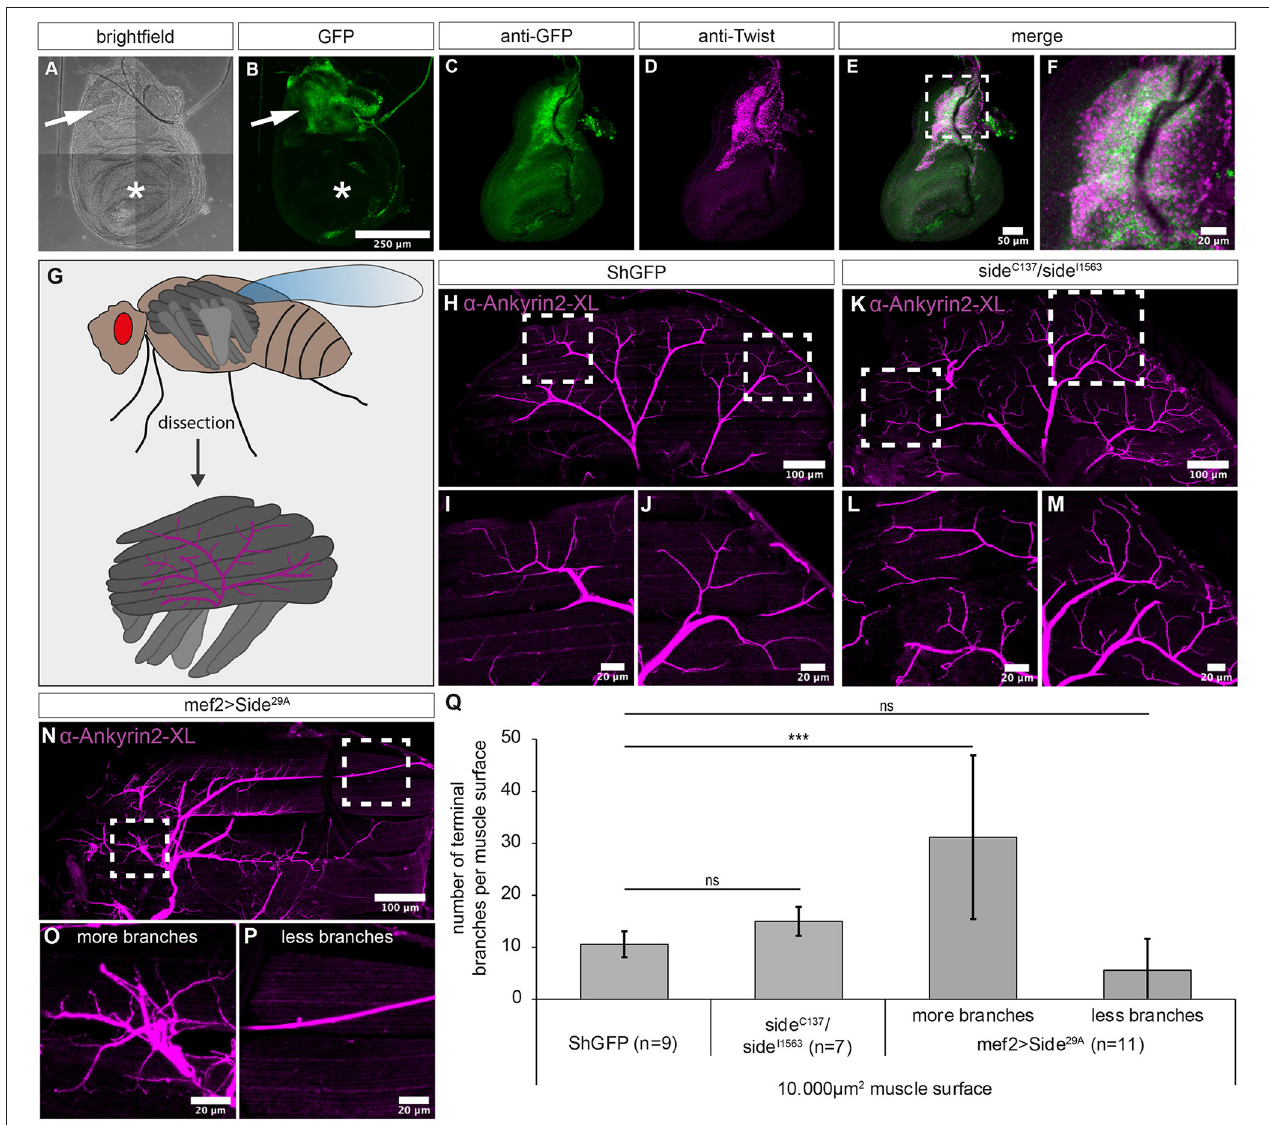
FIGURE 4 | Overexpression of Side causes motor axon targeting errors in indirect flight muscles. (A–F) Projections of confocal micrographs acquired from dissected wing imaginal discs of late SideGFP Mi 00149 third instar larvae. (A,B) Tile scan of a wing disc showing Side-GFP expression only in the notum (arrows). Asterisks mark the wing pouch. (C–F) Side-GFP largely overlaps with Twist-expressing myoblasts in wing discs. (G) Top: Scheme of indirect (dark grey) and direct (grey) flight muscles and the mesothoracic jump muscle (light grey, exterior view). Bottom: Tentative scheme of the innervation pattern of indirect flight muscles by the posterior dorsal mesothoracic nerve (PDMN, magenta) as seen in dissected hemi-thoraces (interior view). (H–P) Confocal projections of dissected hemi-thoraces stained with anti-Ankyrin2-XL antibodies of control and Side loss- and gain-of-function flies. (H–J) The PDMN defasciculates into five major branches that cover the entire surfaces of all six dorsal longitudinal flight muscles. Several nerve branches emanating from these fascicles sprout fine processes even between and along individual myofibrils. (K–M) Indirect flight muscles of side mutants show more secondary nerve branches compared to control flies. (N–P) Muscle-specific overexpression of Side results in irregular innervation of indirect flight muscles, with areas containing increased number of branches (O) , while others are largely devoid of nerve branches (P) . (Q) Statistical analysis of the number of terminal branches per muscle surface area (10,000 µ m 2 ). White frames mark regions enlarged in new micrographs in F,I,J,L,M,O,P. Data are means ± SD, n = number of hemi-thoraces. One-way ANOVA, *** P < 0.001, ns, not significant. Genotypes: yw; + ; SideGFPMi00149; w ; + ;ShGFP, w; + ;side C 137 , ShGFP/side I 1563 , ShGFP, w; + ;Mef2-Gal4, ShGFP/UAS-Side 29 A .